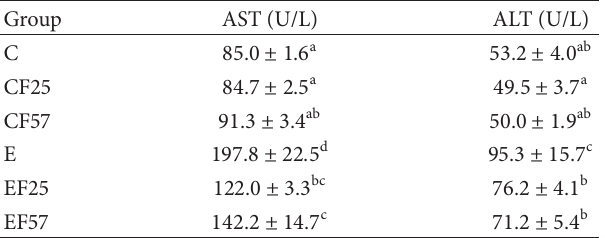
Table 4: Effects of fish oil on plasma aspartate transaminase (AST) and alanine transaminase (ALT) activities in rats under chronic eth- anol feeding 1,2